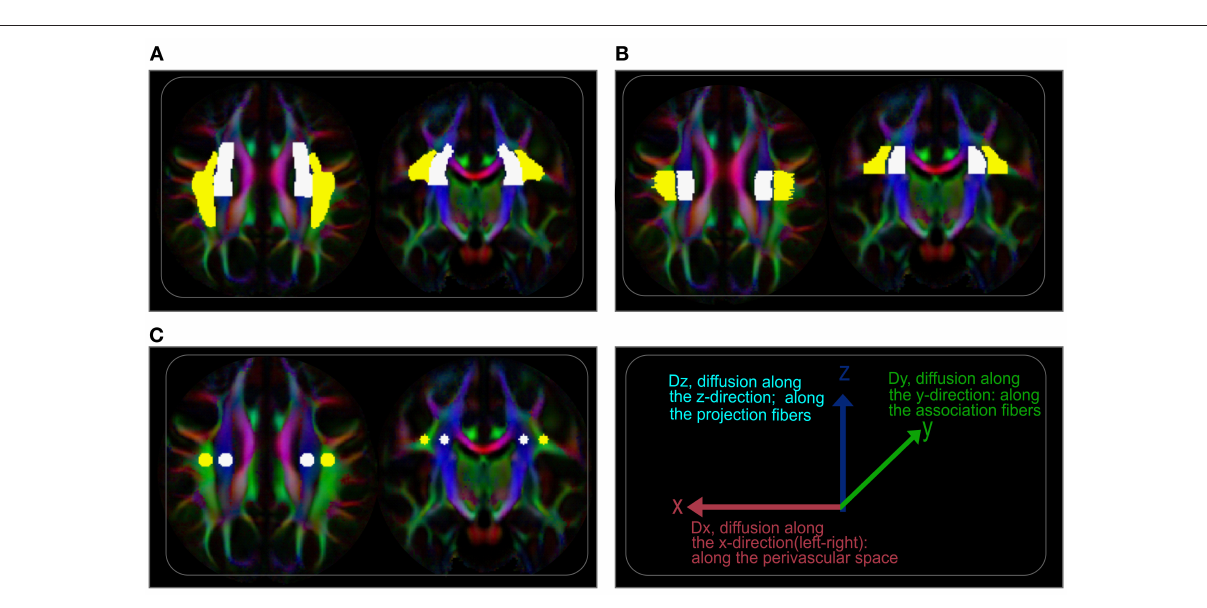
dominating fibers—the projection fibers (in the z-direction; blue; Figure 1C ) and association fibers (in the y-direction; green; Figure 1C )—through which medullary veins run ( Figure 1B